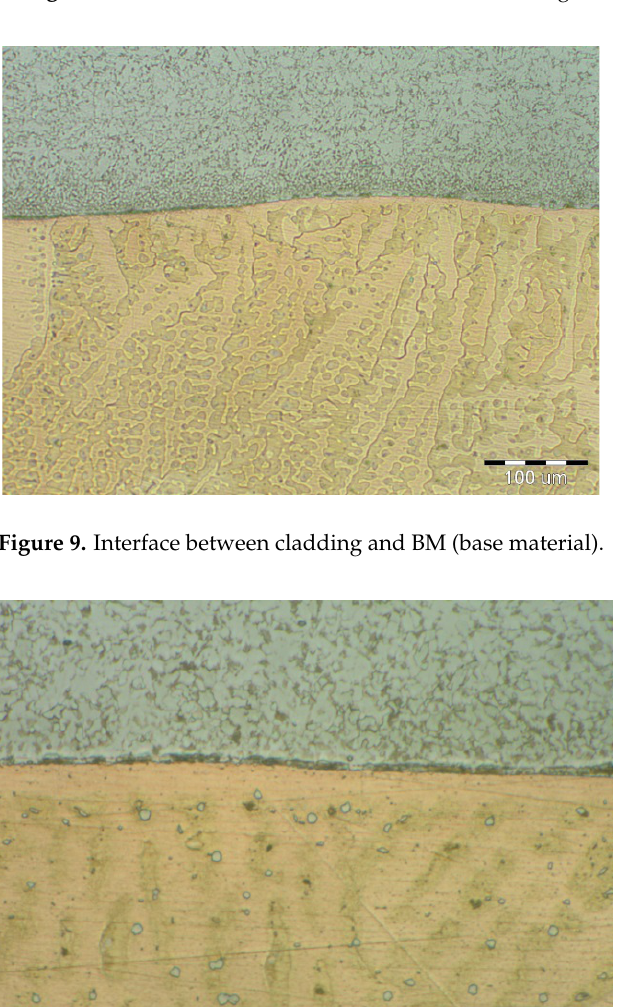
Figure 10. Magnified view of interface between cladding and BM (base material).